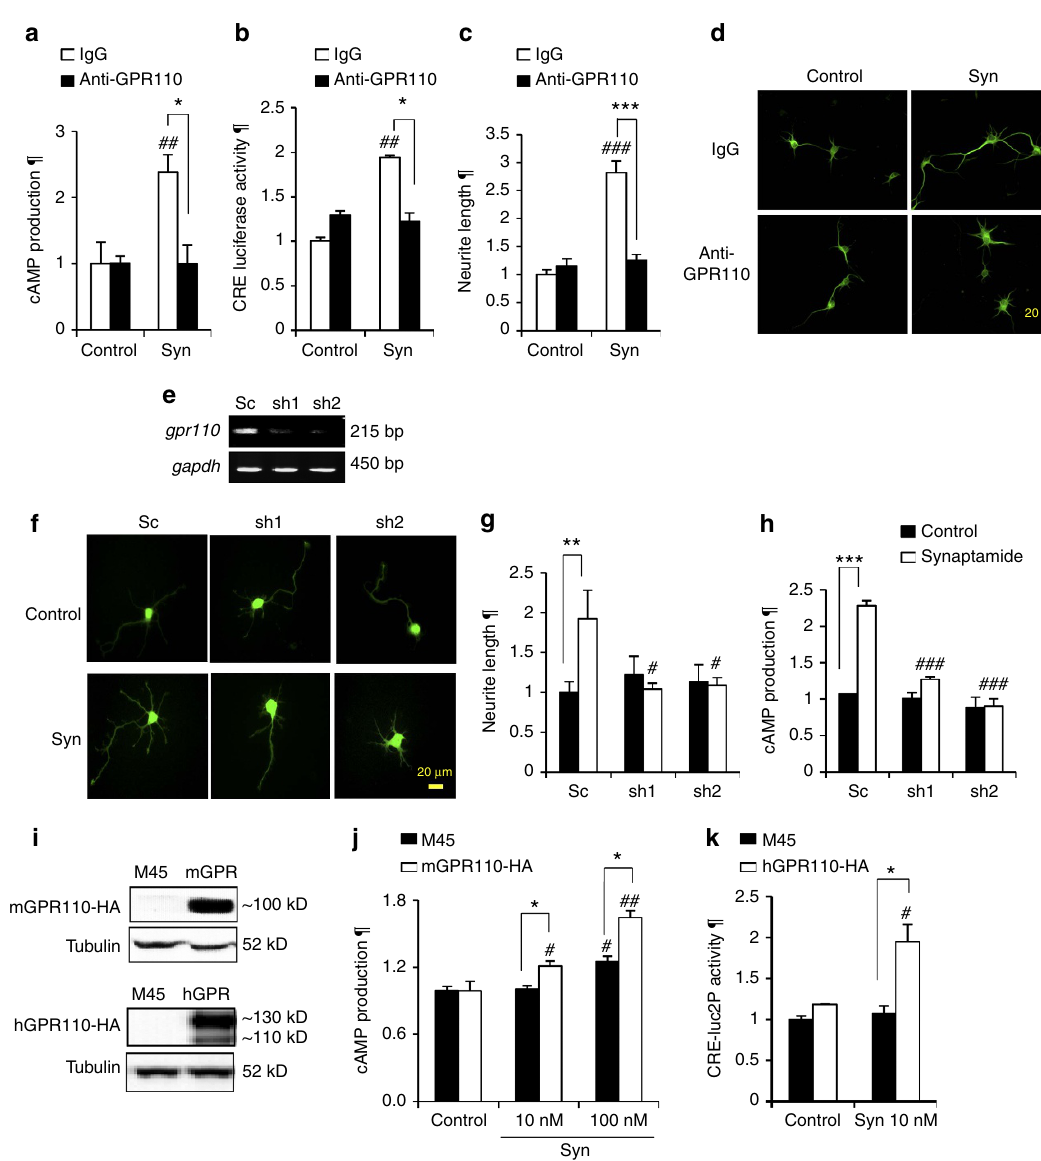
Figure 5 | Synaptamide-induced cAMP production and neurite outgrowth affected by GPR110 knockdown, pretreatment with anti-GPR110 antibody or GPR110 overexpression. Cortical neurons were pre-treated with 0.4 m gml (cid:2) 1 N -terminal targeting anti-GPR110 antibody for 30min on DIV1 or DIV3, and incubated with 10nM synaptamide for 48h or 10min for the evaluation of neurite outgrowth or cAMP production, respectively. The GPR110 antibody pretreatment abolished synaptamide-induced increases in cAMP ( a ), CRE activity ( b ) and MAP2-immunostained neurite outgrowth ( c , d ). Transfection of cortical cells with GFP-expressing GPR110 shRNAs (sh1 and sh2) performed on day 0 effectively suppressed GPR110 expression on DIV3 ( e ). shRNA expression prevented synaptamide-induced neurite outgrowth ( f , g ) and cAMP production ( h ) while scrambled control RNA (Sc) showed no effects. For cAMP assay, transfected cortical cells were treated with 10nM synaptamide on DIV3 for 10min. Neurite outgrowth was evaluated for transfected (GFP-positive) cells after treatment with 10nM synaptamide on DIV1 for 2 days. Overexpression of HA-tagged mGPR110 in A549 cells or HA-tagged hGPR110 in CRE-luc2P HEK cells for 24h ( i ) significantly increased cAMP production after 10min stimulation with 10–100nM synaptamide compared with the M45 empty-vector expressing cells ( j , k ). Data represent three independent experiments. Values are shown as means ± s.e.m. of biological triplicates ( n ¼ 3). * P o 0.05, ** P o 0.01, *** P o 0.001, # P o 0.05, ## P o 0.01, ### P o 0.001 by unpaired Student t -test versus the corresponding control. z , relative to control. Scale bars, 20 m m ( d , f